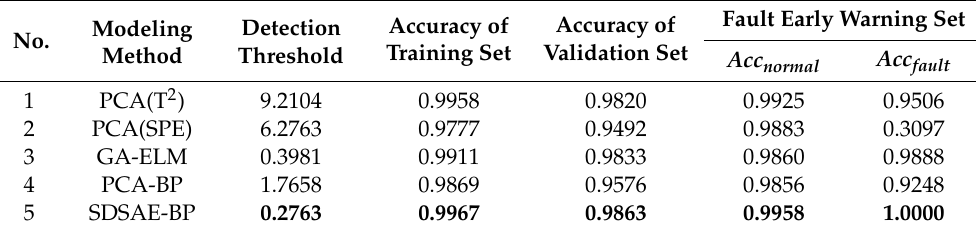
Figure 21. Fault early warning performance of comparative feature reduction methods. Table 5. Performance comparison of feature reduction